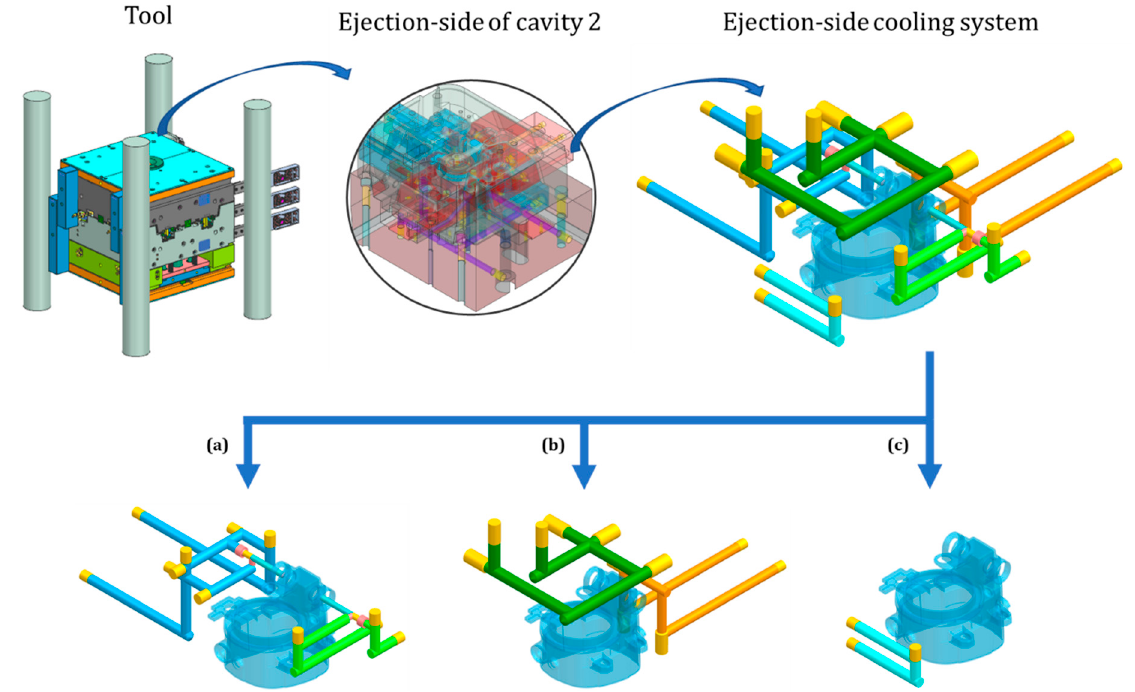
Figure 2. View of the tool showing details of the ejection side of cavity 2, the conventional cooling system, and individual conventional cooling channels with products ( a – c ).